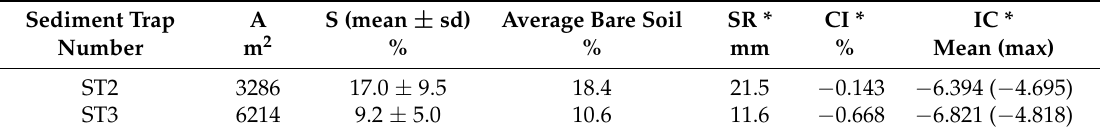
Table 2. Physiographic characteristics of the upslope contributing area of the two sediment traps. Sediment Trap